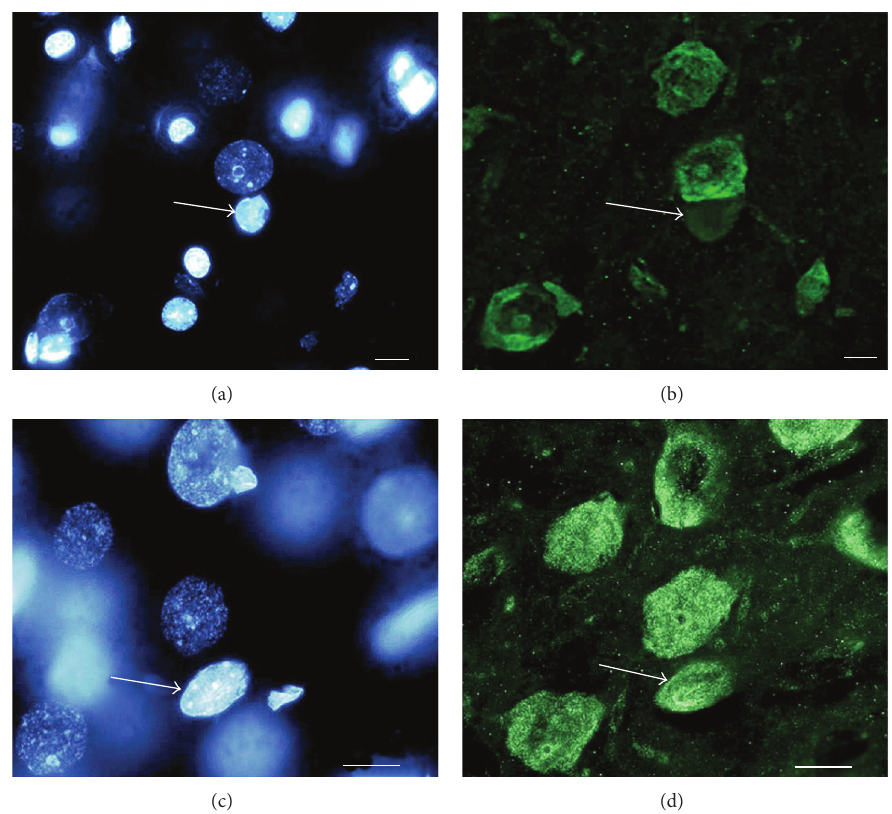
Figure 10: NeuN expression in oligodendrocytic nuclei. (a) In the center of the visual field, a large, dark neuronal nucleus (euchromatin) is observed. A small, bright oligodendrocytic nucleus (heterochromatin) is visible below the nucleus of the neuron (arrow). Ten oligodendrocytes can be observed in the section area, in addition to the nucleus marked with an arrow. (b) The same visual field under a green filter. Neuronal nuclei are green. All 10 extraneous oligodendrocytic nuclei are not visible (they do not contain a neuronal marker), but the oligodendrocytic nucleus under the neuron (arrow) remained visible. It is also immunoreactive to NeuN, but much less so compared to the neuron above. ((c), (d)) A later stage heterokaryon’s transformation. In the center of the visible area, a dark, round neuron’s nucleus is located near the light, similarly sized oligodendrocytic nucleus (arrow). The large size of the oligodendrocyte’s nucleus indicates a long reprogramming duration. (c) The expression level of the neuronal marker NeuN in the oligodendrocyte’s nucleus (arrow) does not differ from the neuron’s nucleus. ((a), (c)) Staining with the fluorescent dye DAPI. ((b), (d)) Immunocytochemistry with NeuN labeled with Alexa 488. The scale bar is 10 𝜇 m.